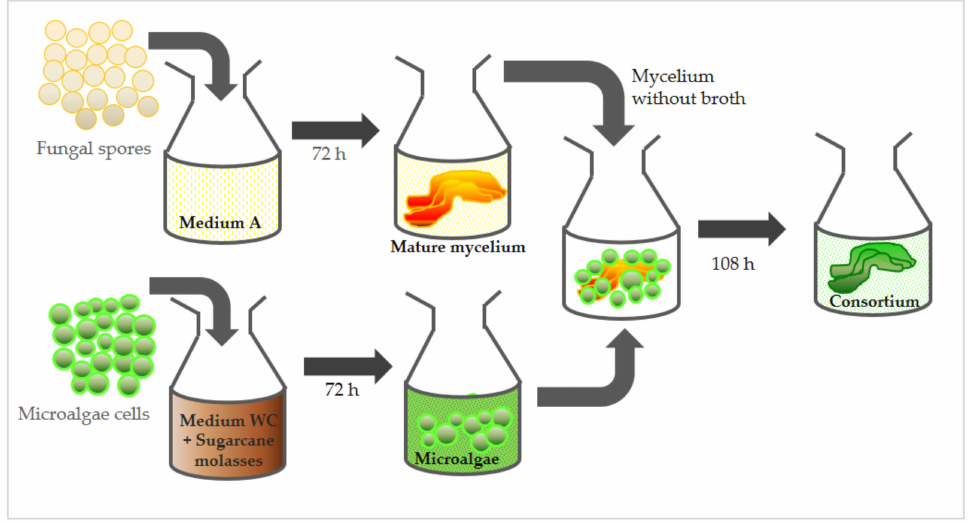
Figure 1. Scheme with sequence of steps for the formation of an algae-fungus consortium with S. obliquus and M. circinelloides